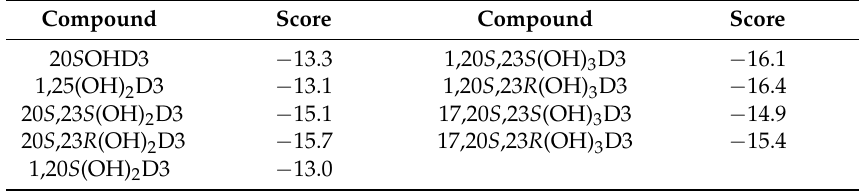
Table 14. Glide XP scores of vitamin D3 analogs docked into the refined human AhR LBD model. Compound Score Compound